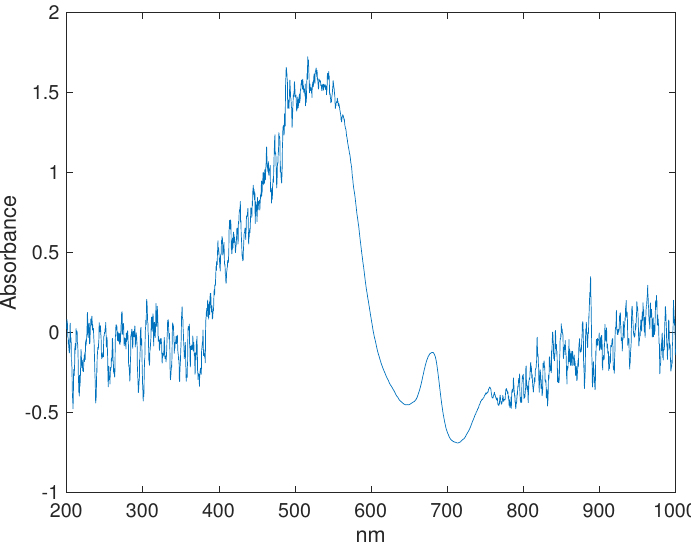
Figure 2. Absorbance Spectra of Beauty Sweet